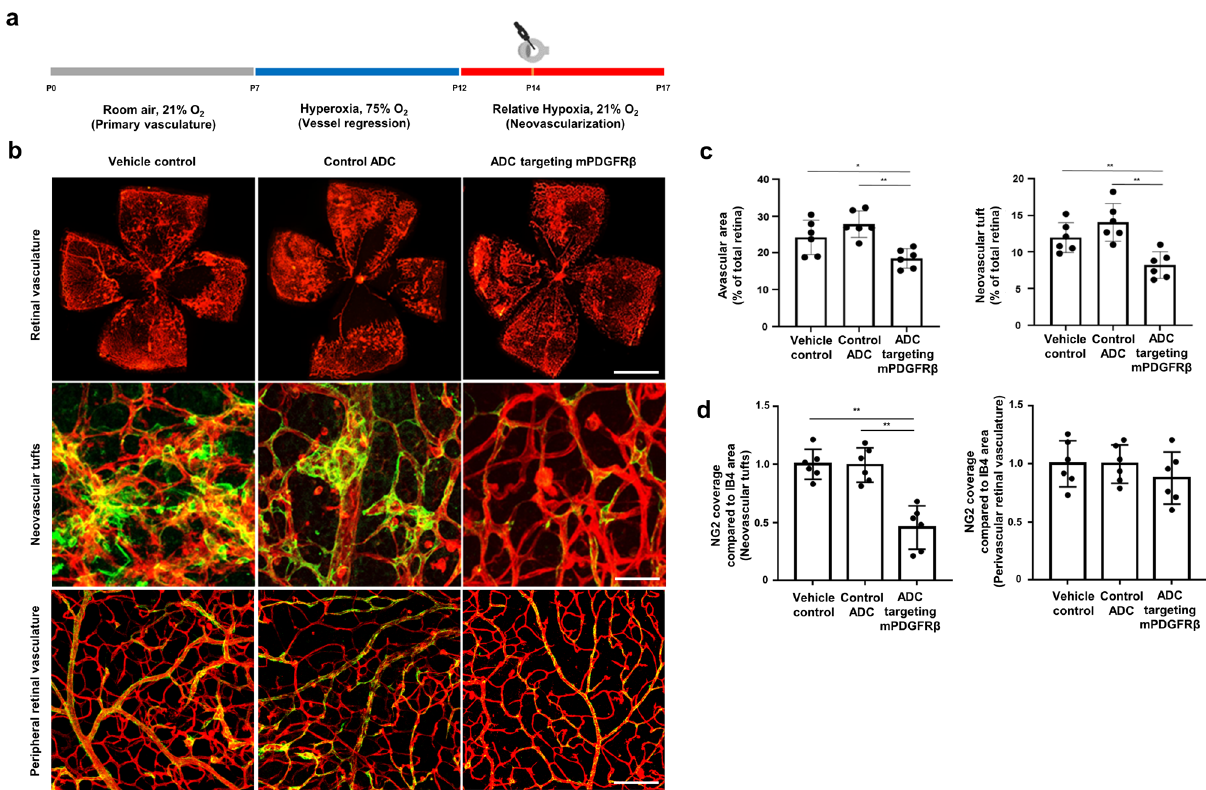
Fig. 3 ADC targeting mPDGFR β ameliorates retinal neovascularization in the OIR model. a Schematic experimental timeline of antibody-drug conjugate (ADC) administration and tissue preparation in the oxygen-induced retinopathy (OIR) mouse model. OIR-induced pups were treated with vehicle control, control ADC, or ADC targeting mouse platelet-derived growth factor receptor β (mPDGFR β ) through intravitreal injection at P14. Three days after treatment, the mouse eyeballs were dissected to prepare whole-mounted retina samples. Phosphate-buffered saline (PBS) was used as the vehicle control. Anti-human epidermal growth factor receptor 2 (HER2) × cotinine complexed with cotinine-duocarmycin was used as a control ADC; anti-HER2 scFv was derived from trastuzumab. b Representative immuno fl uorescence images of whole-mounted retina samples from OIR pups stained with isolectin B4 (IB4, red) and neural/glial antigen 2 (NG2, green) to visualize the retinal vessels and pericytes. Scale bars on the top, middle, and bottom correspond to 500 μ m, 100 μ m, and 150 μ m, respectively. c Quanti fi cation of the avascular area and neovascular tuft area. The avascular area and neovascular tuft area were quanti fi ed and presented as percentages of the total area of the retina. All data were analyzed using NIH ImageJ software, and values are presented as percentages of the mean ± SEM ( n = 6 mice for each data set). * P < 0.01, ** P < 0.001, obtained using one-way analysis of variance (ANOVA) and Tukey ’ s post-hoc tests. d Quanti fi cation of NG2 coverage of IB4 + vessels at the mid-peripheral region (pathological neovascular tuft area, left) and peripheral region (peripheral vascularized area, right), respectively in the whole-mounted retinas. All data were analyzed using a built-in measuring tool, the LAS X system (Leica Microsystems Ltd., Wetzlar, Germany). Error bars represent standard error mean (SEM, n = 6 mice for each data set). ** P < 0.001, obtained using one-way ANOVA and Tukey ’ s post-hoc tests. Source data are provided as a Supplementary Data fi